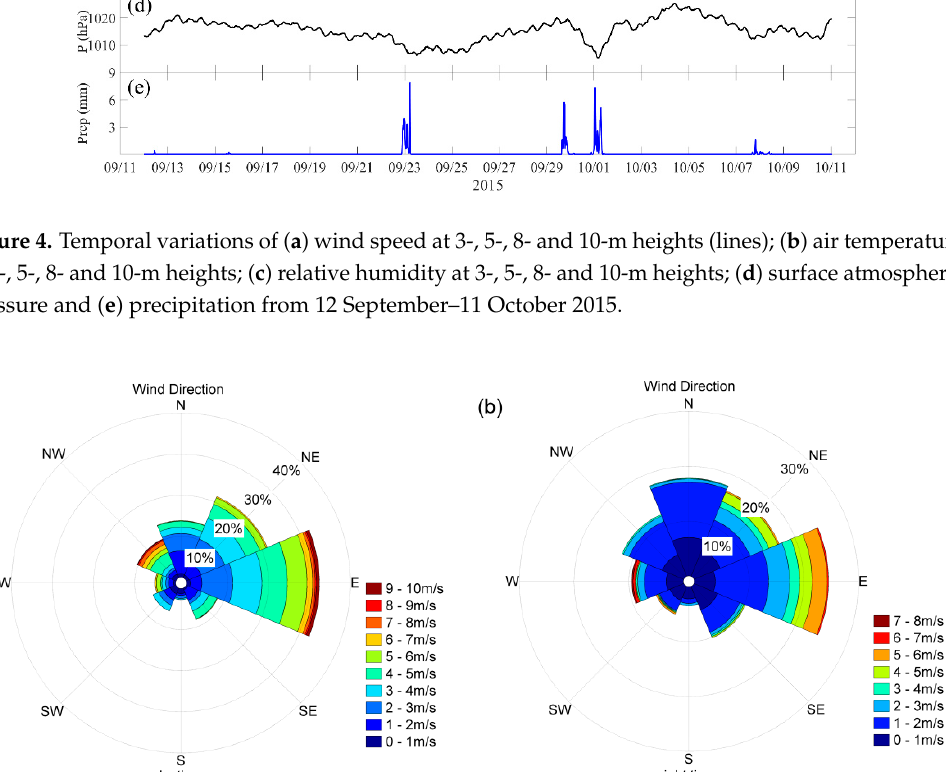
Figure 5. Distributions of ( a ) wind directions at 10-m height during the daytime and ( b ) wind directions at 10-m height during nighttime.